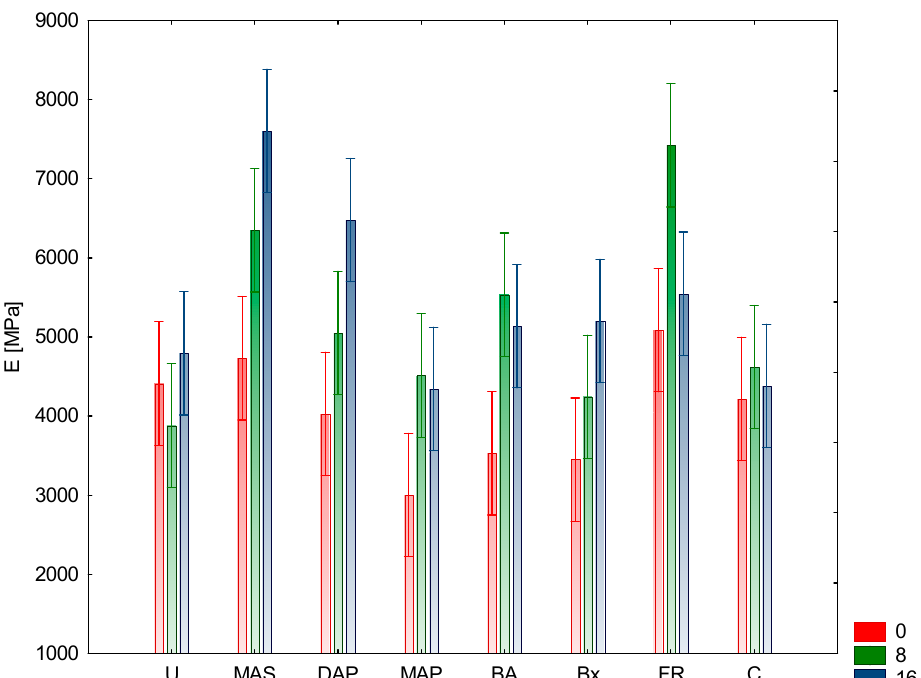
Figure 1. Illustration of the E relationship of aging cycles and chemical compounds. Whiskers represented 95% confidence interval.